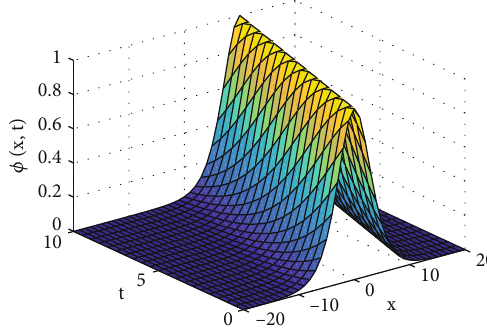
Figure 7: 3D image of numerical results of time fractional BBMB- equation for x ε ½ − 20, 20 (cid:2) , α = 0 : 5 , Δ t = 0 : 001 , β = 1 , and h = 0 :